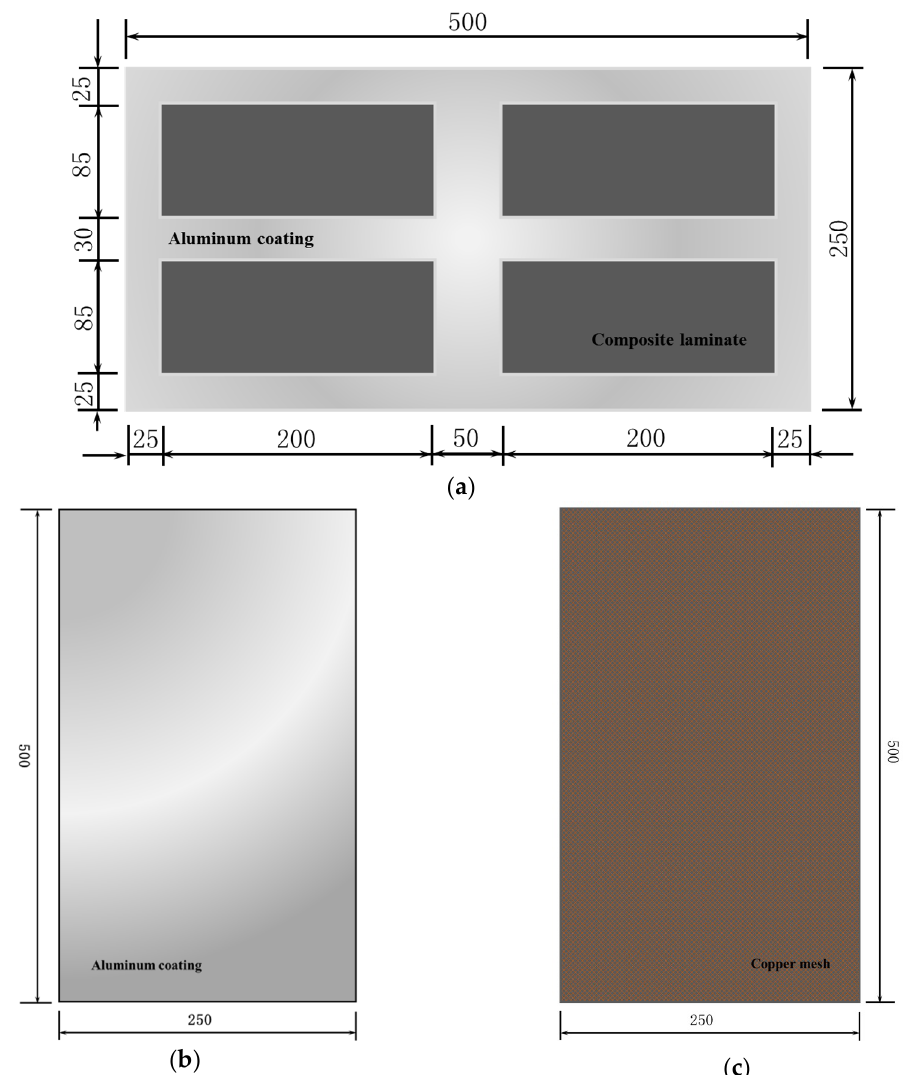
Figure 3. Three types of lightning protection structures for composite-reinforced panel: ( a ) the local-sprayed aluminum coating; ( b ) the full-sprayed aluminum coating; ( c ) the full-embedded copper mesh filling. (Unit: mm).